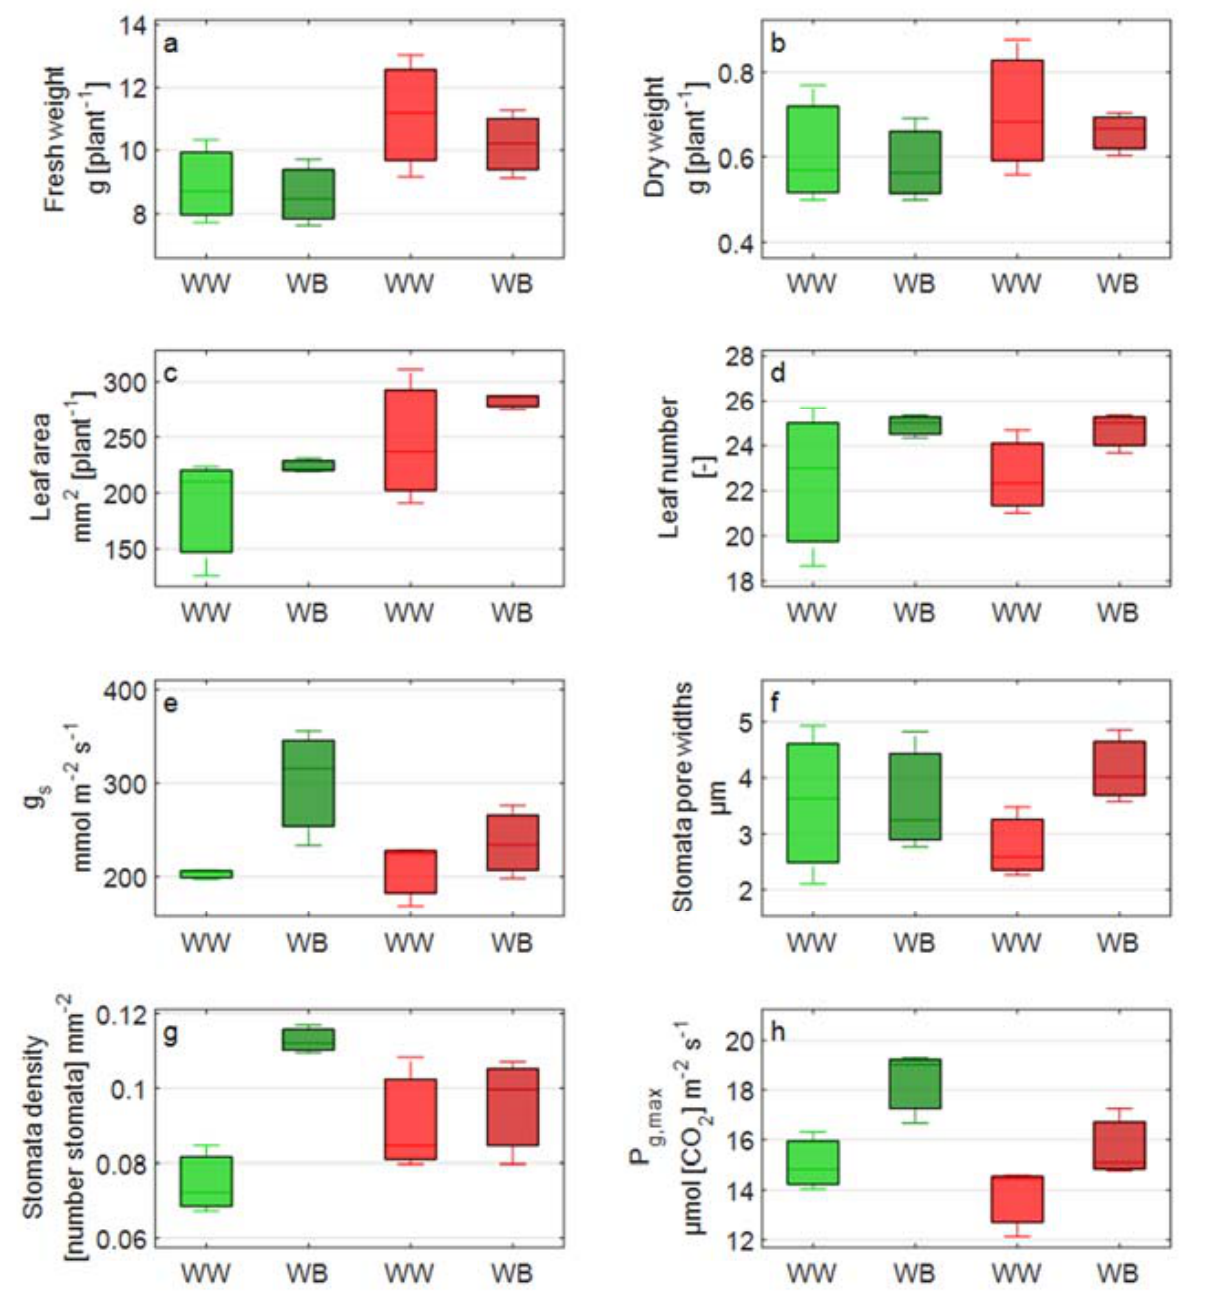
Figure 4. Boxplot overview of the measured variables: ( a ) plant fresh weight; ( b ) plant